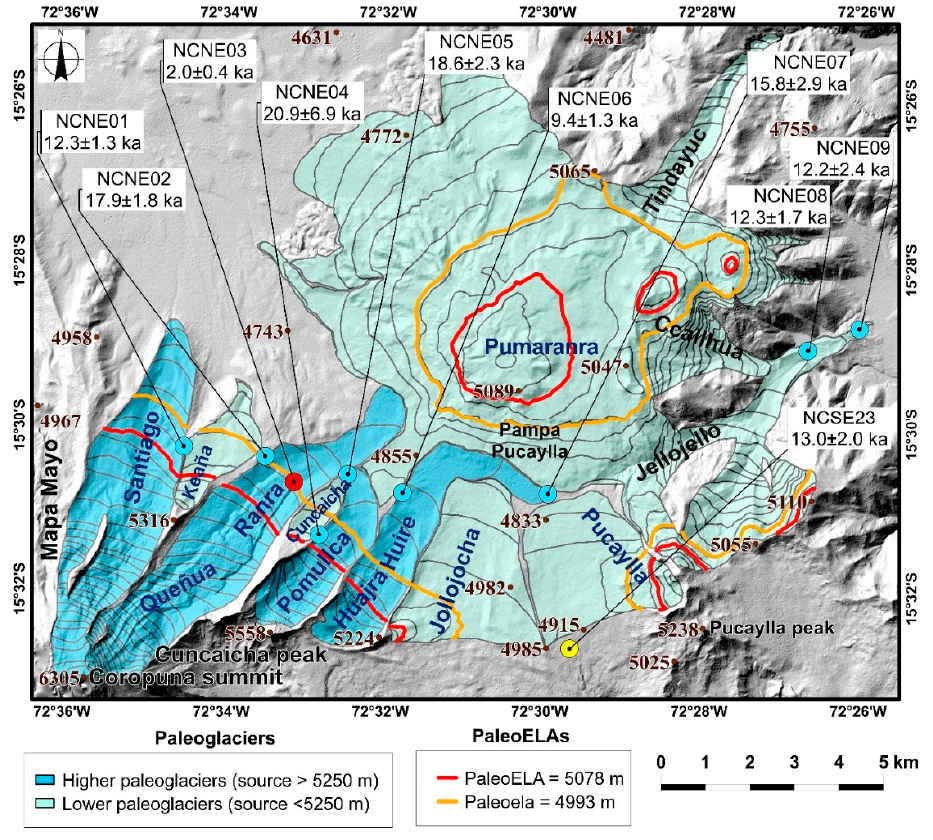
Figure 7. Reconstruction of the highest and lowest paleoglaciers, and the paleoELAs of highest paleoglaciers (paleoELA 1 , red) and all the paleoglaciers (paleoELA 2 , yellow). The other symbology is the same as in Figure 4.